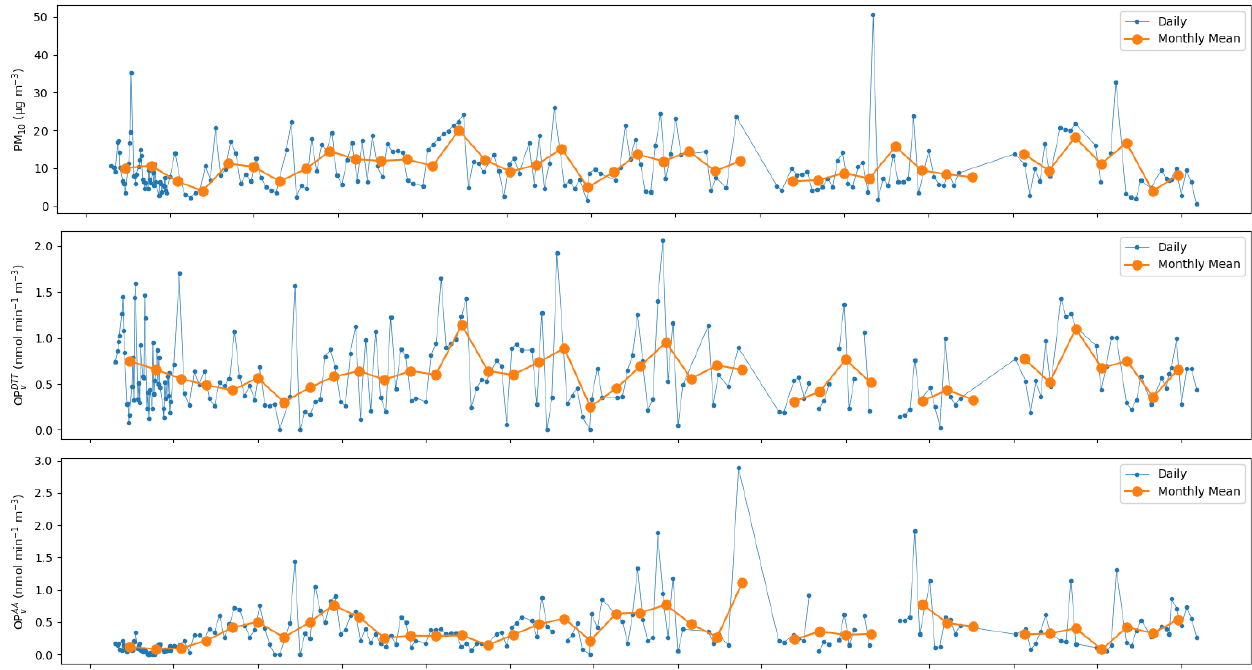
Figure 9. Temporal distributions of observed PM 10 and OP activity (OP DTT v and OP AA v ) from the year 2017 to 2020 at the OPE site in terms of daily and monthly